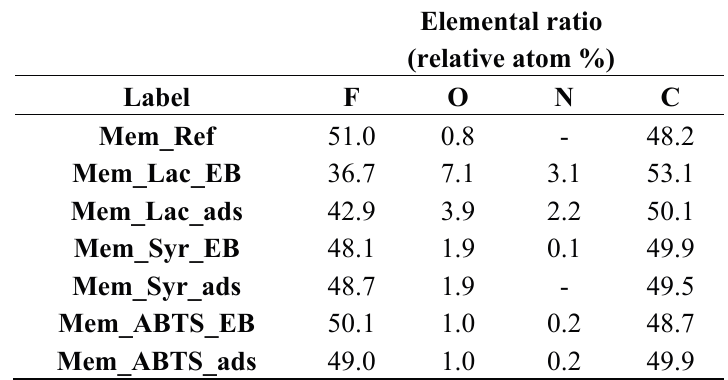
Table 1. Atomic composition at the surface of the membranes after immobilization of laccase, syringaldehyde, and ABTS using E-Beam treatment and physical adsorption, respectively, as determined by XPS